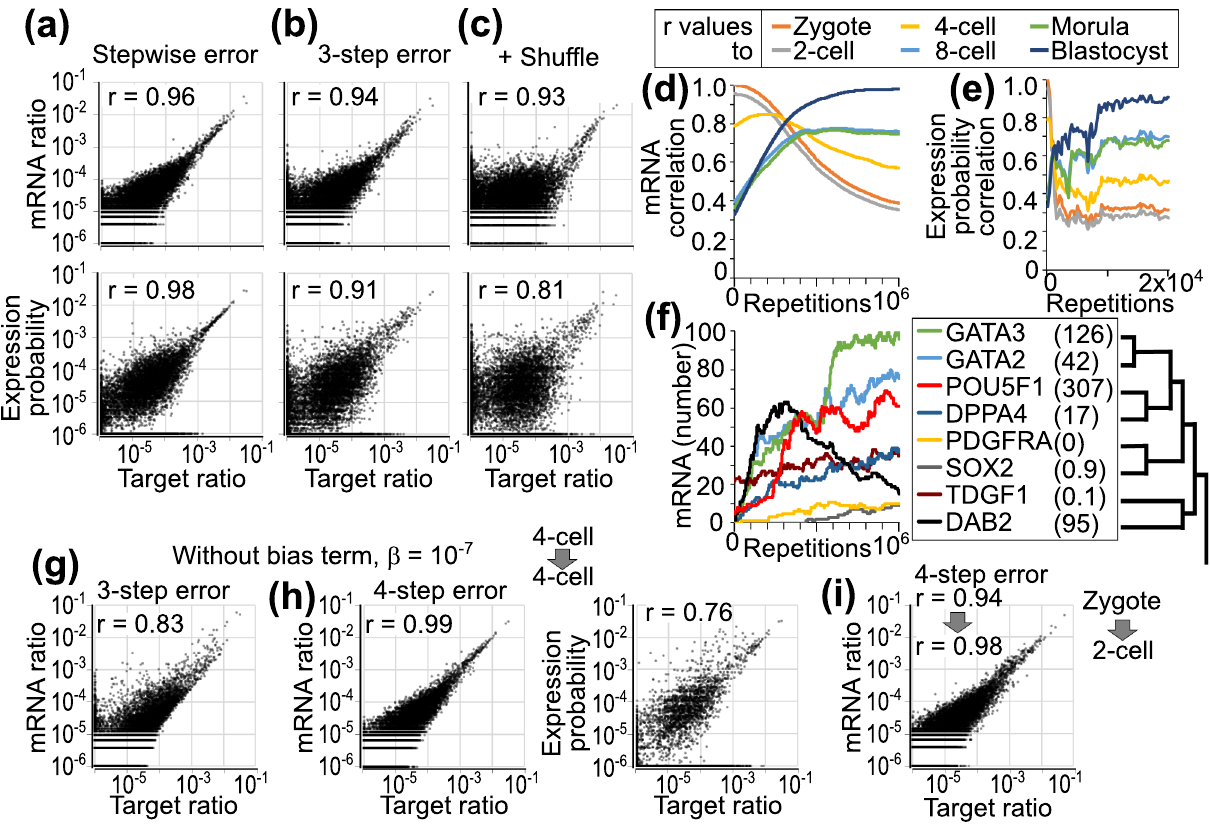
Figure 4. Model with an mRNA pool. In the model with an mRNA pool and hierarchical pairs generated by the AreaSum method, stochastic processes are repeated for 5 × 10 5 times. The expression probability is equivalent to the expression ratio in Fig. 3d. ( a ) The change from zygote to 4-cell stage with stepwise error. ( b – g ) Model with 3-step error. ( b ) The change from zygote to 4-cell stage is tested. ( c ) Initial and target ratios are set with independently shuffled zygote and 4-cell data. Ratios after 10 6 repeats are shown. ( d – f ) Initial and target ratios are set with zygote and blastocyst. Simulation data of mRNA and expression probability are recorded every 250 repeats. ( d ) Correlation coefficient between the mRNA ratio and the indicated scRNA-seq data. ( e ) Correlation coefficient between the expression probability and scRNA-seq data are plotted until 2 × 10 4 repeats. ( f ) The amount of indicated genes in the mRNA pool is plotted. The numbers in parentheses indicate the target level of each gene. The dendrogram indicates the layers in which the genes are paired in the hierarchical pairs. ( g – i ) Bias β is set 10 −7 , not 1, for the homeostatic state. ( g ) Model with 3-step error. Initial and target ratios are set with the same 4-cell data. ( h , i ) Model with 4-step error. ( h ) Initial and target ratios are set with the 4-cell data. ( i ) Initial and target ratios are set with zygote and 2-cell stage. In the dot plots, relative ratios are plotted after adding 10 −6 to all